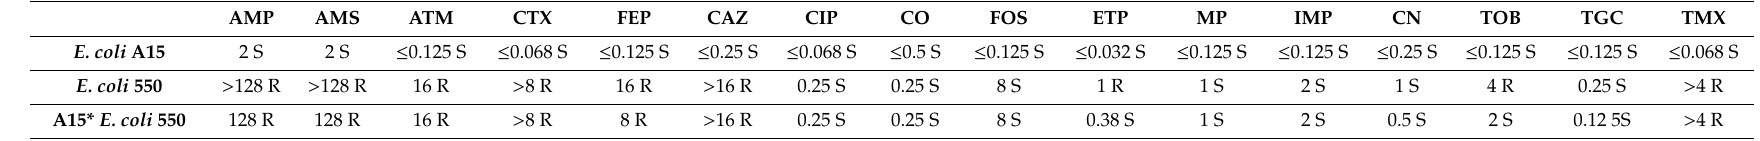
Table 1. Antimicrobial susceptibility profile of E. coli A15, E. coli 550, and the transconjugant A15* E. coli 550 MIC (minimum inhibitory concentration, mg / L).